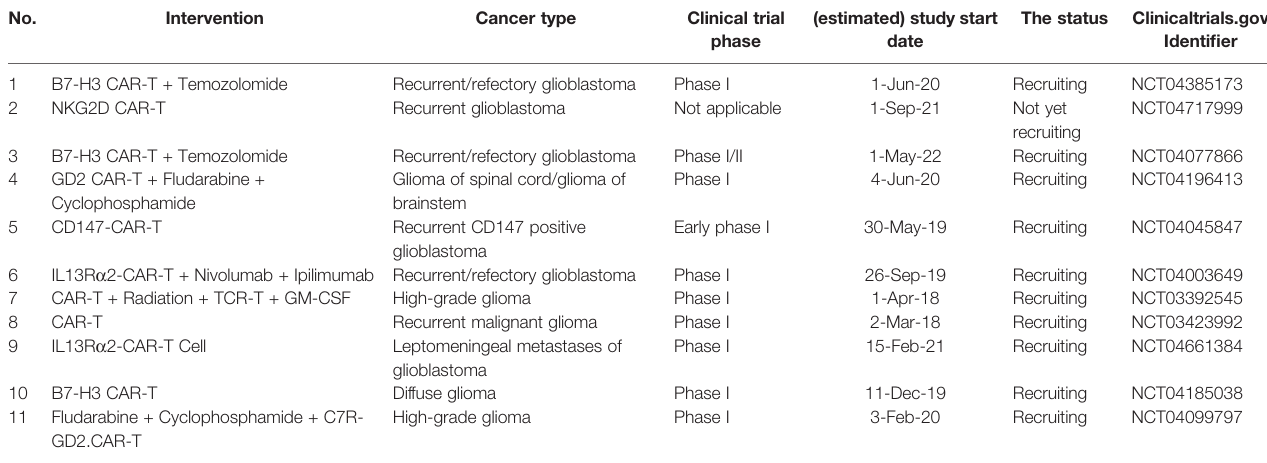
TABLE 5 | The current trend in treating the high-grade glioma patients with CAR-T-based therapy. No.